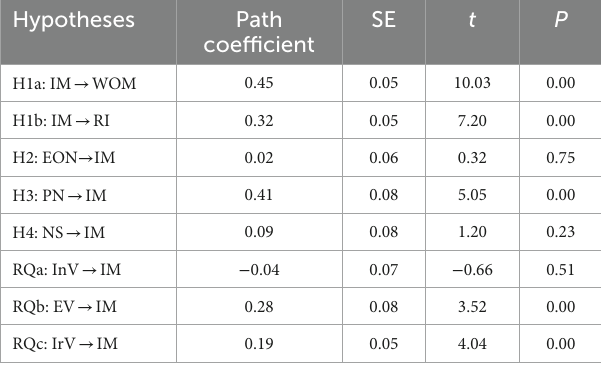
TABLE 5 Hypothesis testing